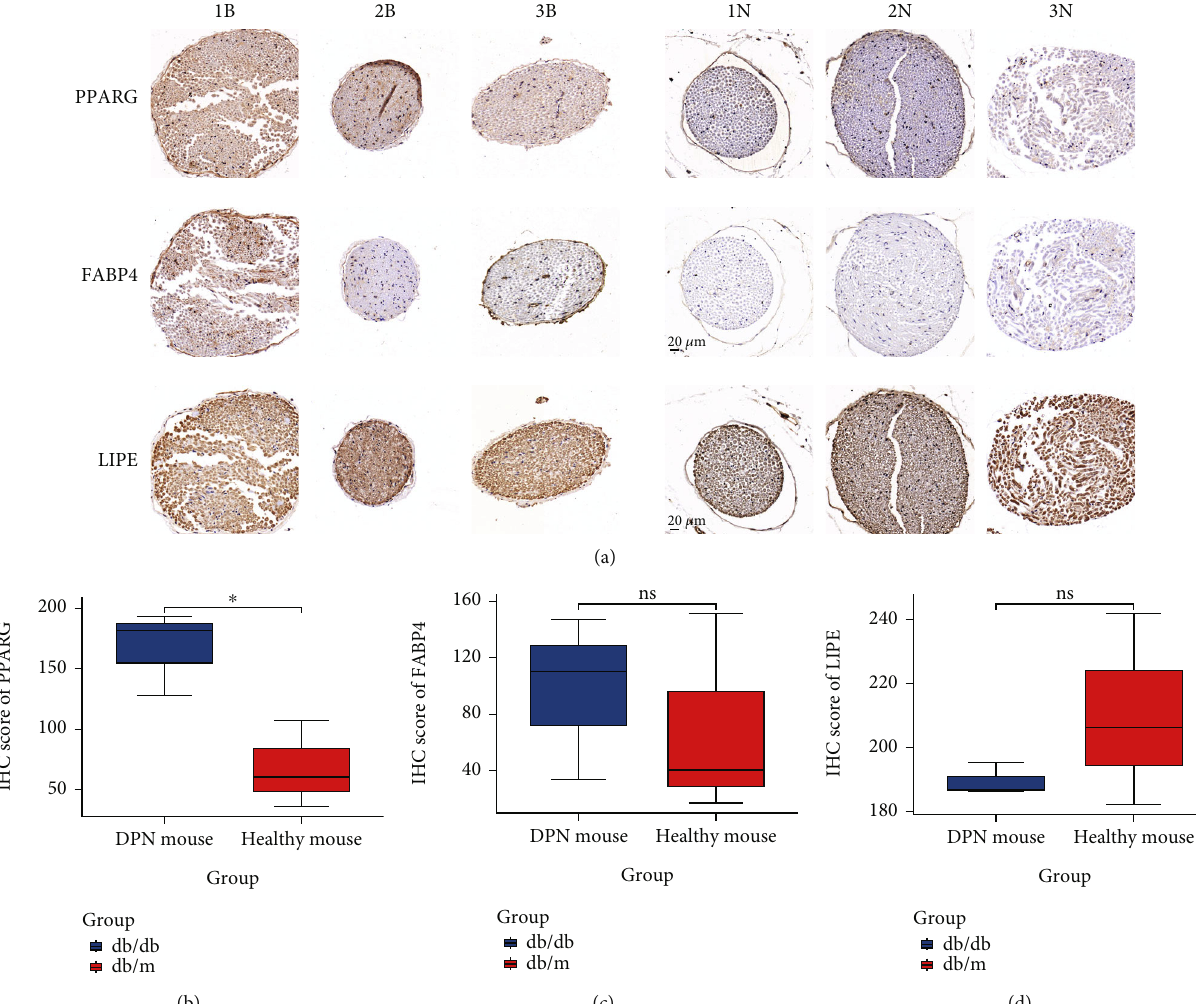
Figure 7: Expression of PPARG, FABP4, and LIPE in sciatic nerve tissues from db/db mice and db/m mice (Magni fi cation ×